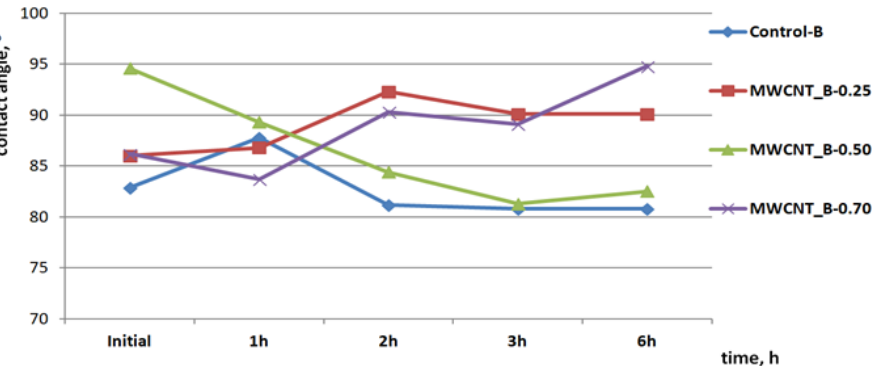
Figure 5. Static and dynamic contact angle of the water drop on the bovine leather surfaces covered with MWCNTs compared with the control sample.